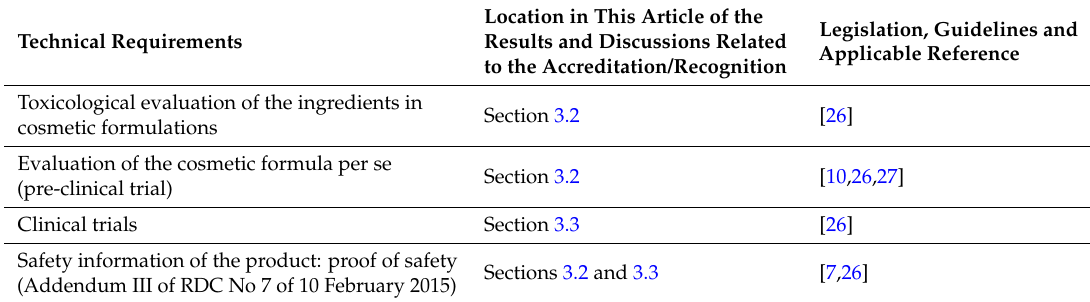
Table 1. Relevant results of the research and development phase of a cosmetic product *.